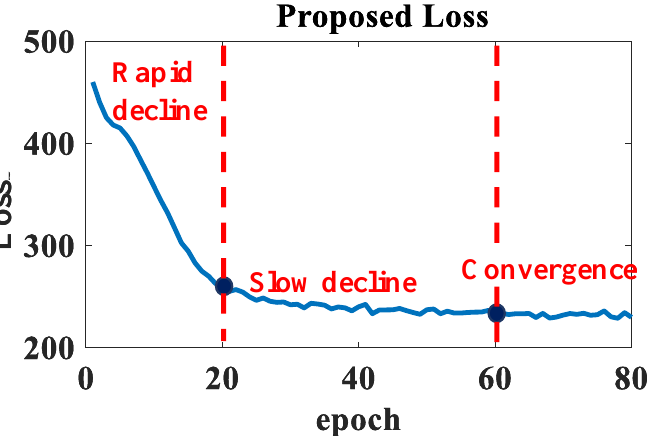
Figure 8. The loss function curve of the Wiener–LSTM model training process. Three stages can be divided among the epoch of the loss function, which include the rapid the decline stage, and the slow decline stage, convenience stage.